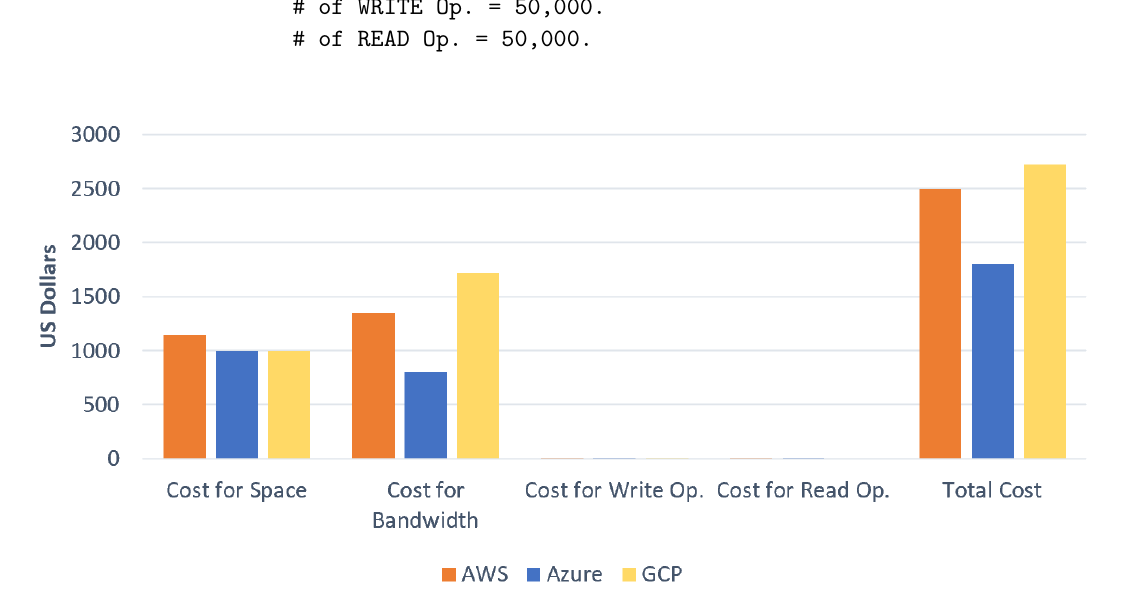
Figure 8. Per-month cost comparison of AWS, Azure, and GCP for 5 TB space, 15 TB bandwidth, 50 thousand write operations, and 50 thousand read